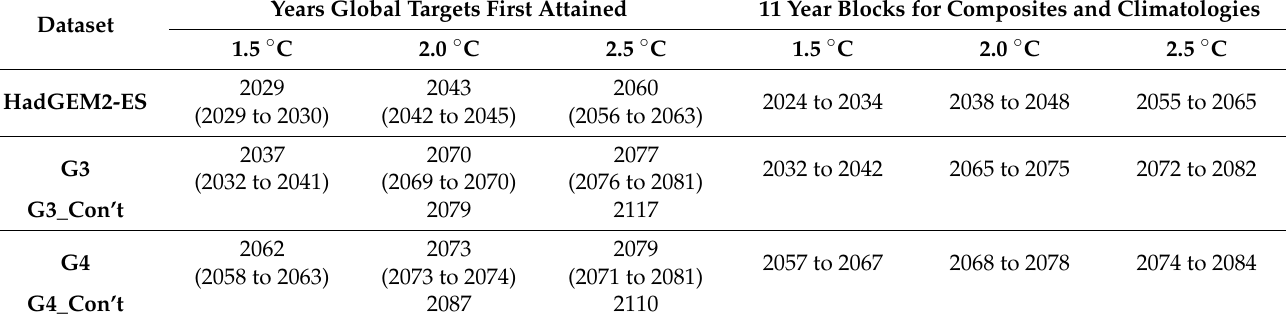
Table 1. List of years when HadGEM2-ES (unaltered and G3 and G4 ensemble means) first attain the 1.5, 2.0 and 2.5 ◦ C global targets. Brackets in columns 2 through 4 indicate the ranges over the individual realizations. Given also are the 11 years blocks used to create the monthly climatology and spatial composite